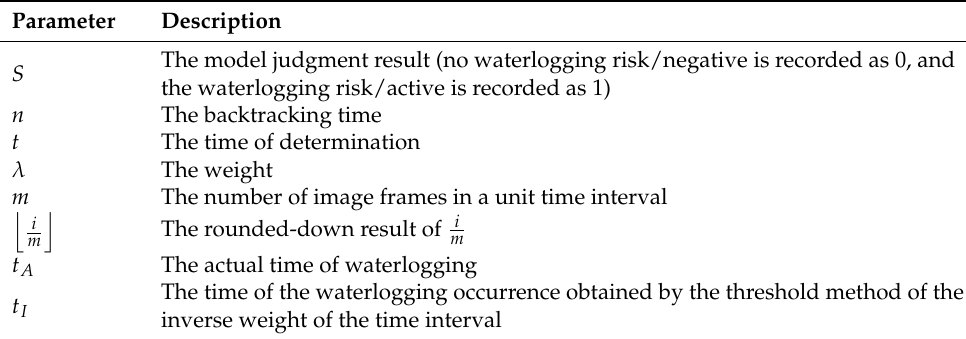
Table 1. Descriptions of the parameters.